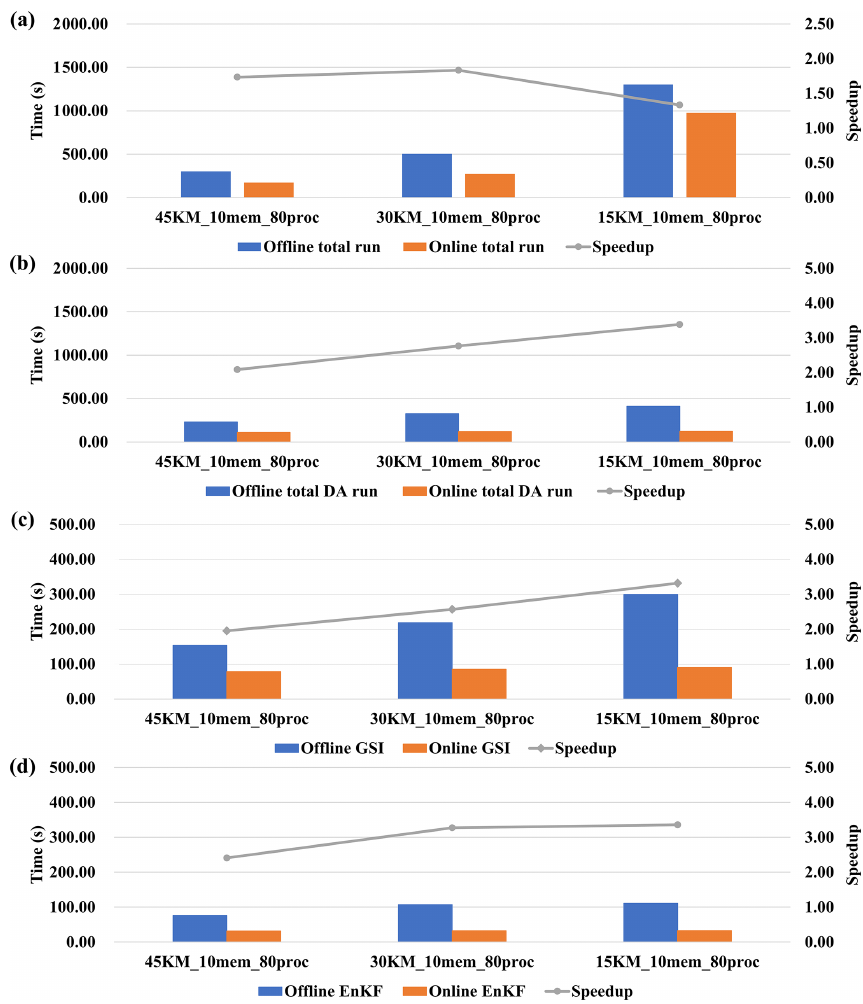
Figure 15. The same as in Fig. 13 but from experiment set 3 in Table 2. Table 3. I/O access statistics corresponding to WRF-GSI/EnKF. Horizontal Number of Number of Total I/O Number of model Total I/O accesses to resolution ensemble observation accesses to ensemble background model ensemble background members prior files observation priors & analysis